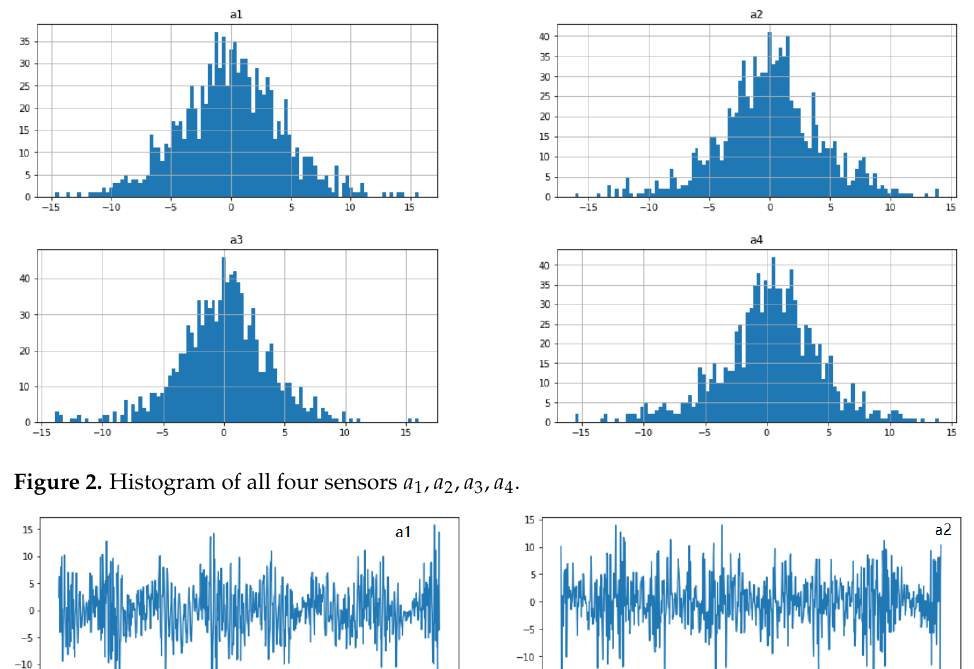
Figure 2. Histogram of all four sensors a 1 , a 2 , a 3 , a 4 .